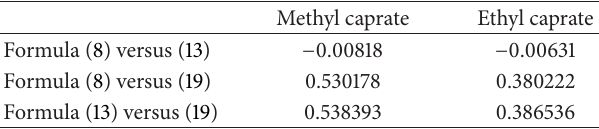
Figure 8: Molecular compressibility’s values calculated from three formulas for ethyl caprate along various isothermals (dots for (8), dotted lines for (13), and lines for (19)). Table 6: OARD % of calculated results for three methods under 303 to 383 K, 0.1 to 210 MPa.